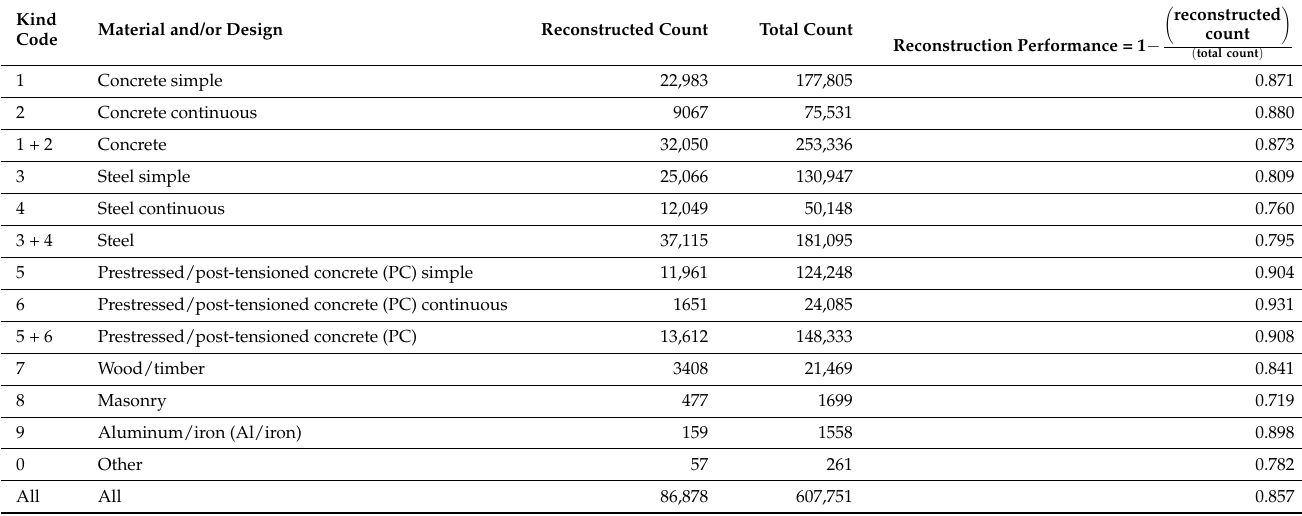
Table 1. Reconstruction performances of bridge materials by counts.